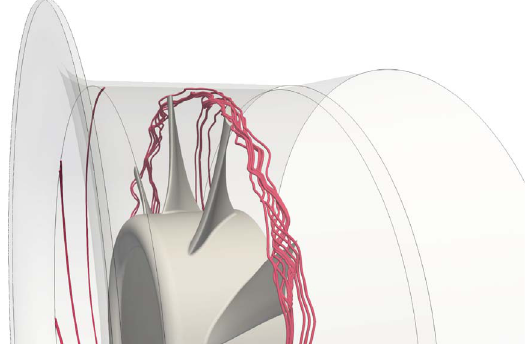
Figure 25. Streamlines of the fl ow through the tip gap, which is interacting with the following blade.